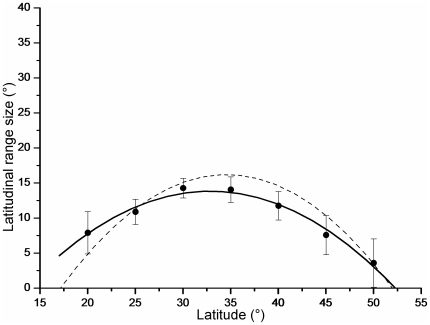
Simulated mean latitudinal range size in each 5° band from 10000 Monte Carlo simulation runs (black points, using mid-point method).The black (y = −24.566+2.409x–0.037x
2, R
2 = 0.971, p <0.0001) and dotted lines show the 2nd order polynomial fits of the predicted and empirical mean latitudinal range sizes respectively.